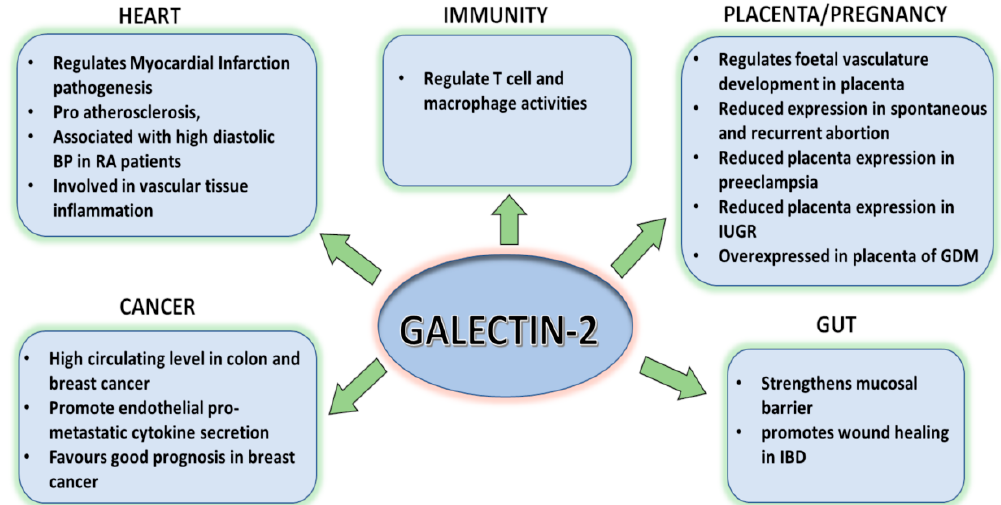
Figure 2. Putative effect of galectin-2 in pathophysiology. Studies in mice have suggested that galectin-2 expression and secretion in the gastrointestinal tract contribute to mucosal barrier maintenance and preserve epithelial architecture. Galectin-2 expression in the placenta has shown to support foetal vasculature development in pregnancy. Galectin-2 has also been reported to be involved in MI pathogenesis and atherosclerosis in the heart. Galectin-2 expression in breast cancer was shown to correlate with good prognosis. Higher level of circulating galectin-2 showed to promote tumour cell hematogenous dissemination and endothelial secretion of metastasis-promoting